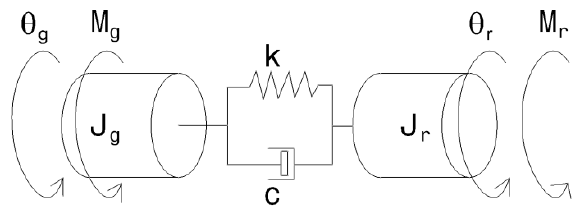
Figure 2. Two-dof lumped-parameters model of the drive train.